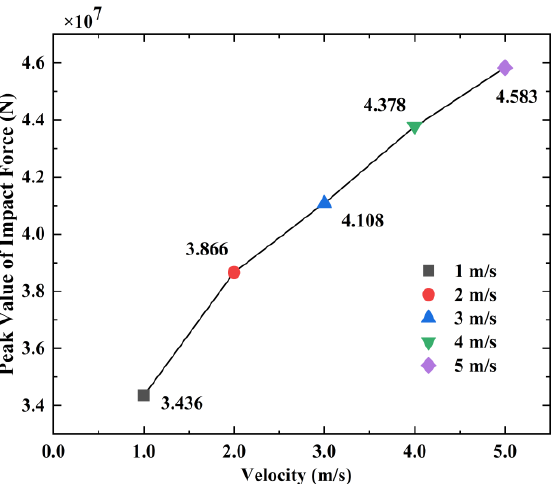
Figure 11. Variation of peak values of impact force at different impact velocities.